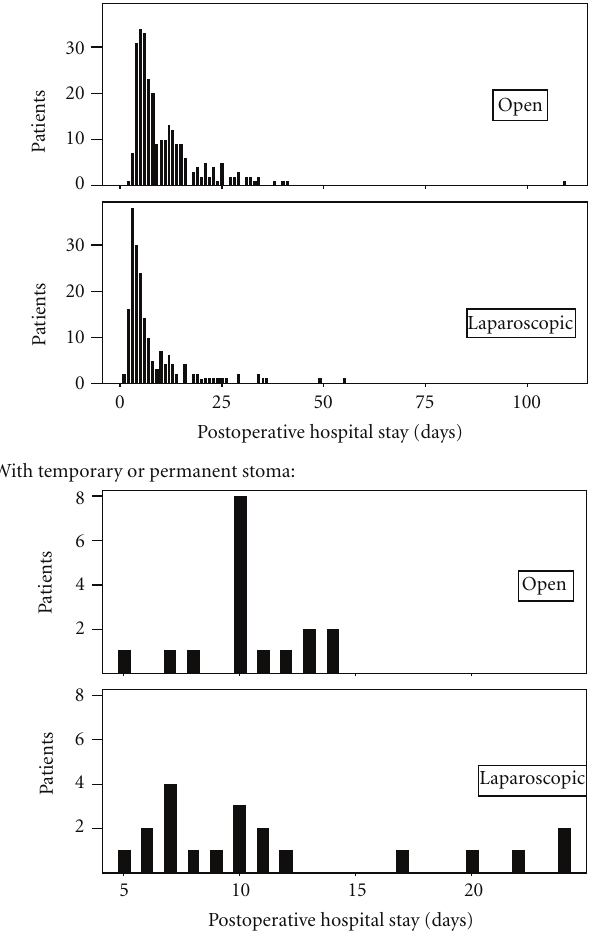
Figure 1: Histogram showing the frequencies of days of postoperative hospital stay after laparoscopic versus conventional open colonic and rectal resections for colorectal malignancies for patients with a stoma and for patients with primary anastomosis. For patients with a stoma there was no significant di ff erence in postoperative hospital stay between laparoscopic and open surgery (median 10 versus 10 days, ns). For patients with primary anastomosis the median postoperative hospitalisation was significantly shorter (4 versus 8 days, P < 0 . 001) after laparoscopic